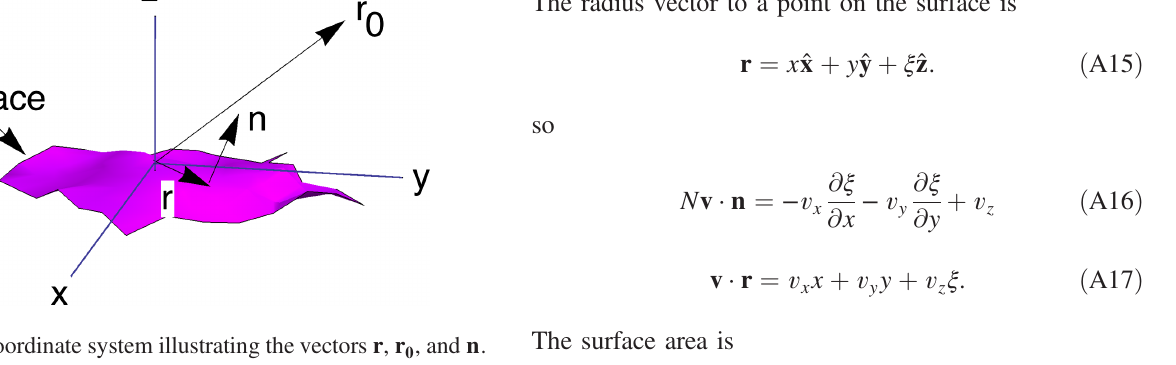
ffiffiffiffiffiffiffiffiffiffiffiffiffiffiffiffiffiffiffiffiffiffiffiffiffiffiffiffiffi